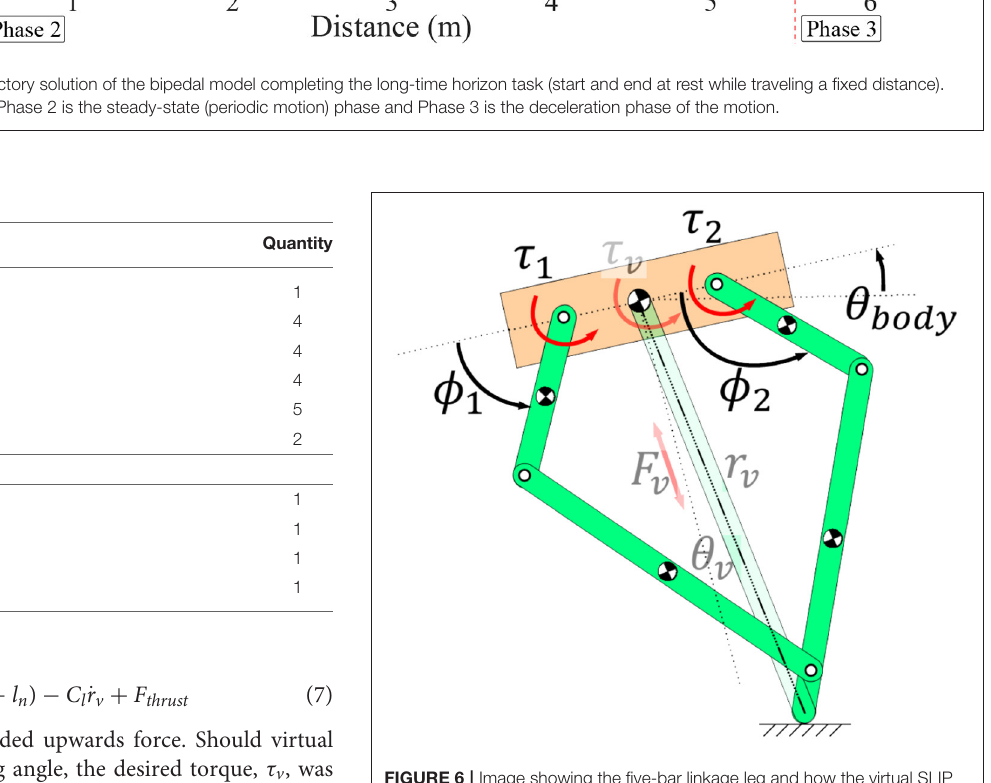
FIGURE 6 | Image showing the five-bar linkage leg and how the virtual SLIP template was calculated with respect to the leg. See Figure 3 for a description of the generalized